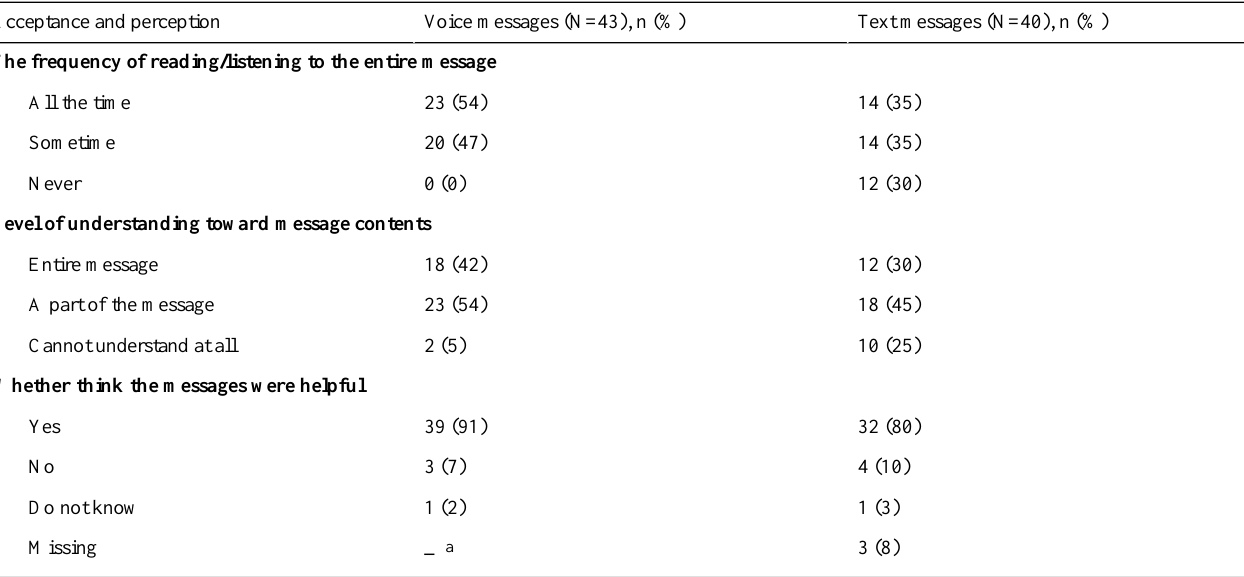
Table 2. Participants’ acceptance and perceptions of voice messages and text messages (of 54 participants, 51 completed the feedback survey, 40 responded that they had received text messages, and 43 responded that they had received voice